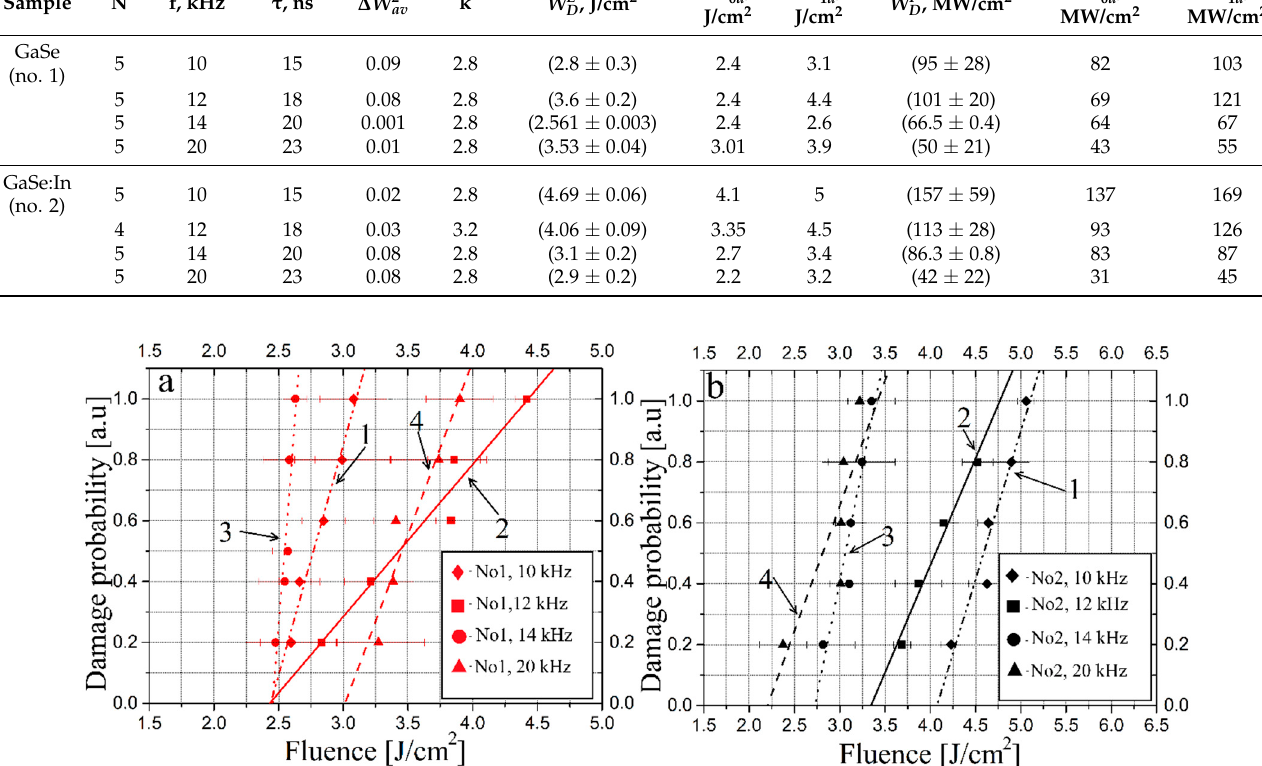
Figure 6. ( a ) Dependences of the sample no. 1 (GaSe) damage probability on the fluence of the acting radiation (exposure